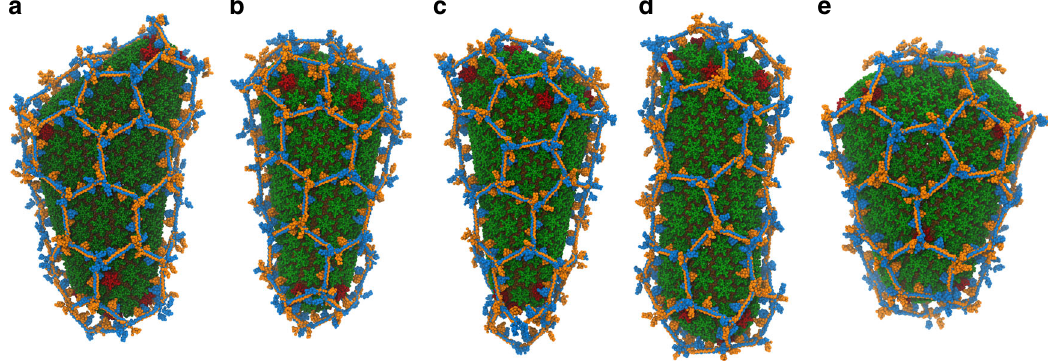
Fig. 7 TRIM5 α binds to multiple capsid morphologies. a – e Note the presence of pentameric and heptameric defects. CG capsid morphologies were derived from directly fi tting cryo-ET data of the core structure collected from intact virions